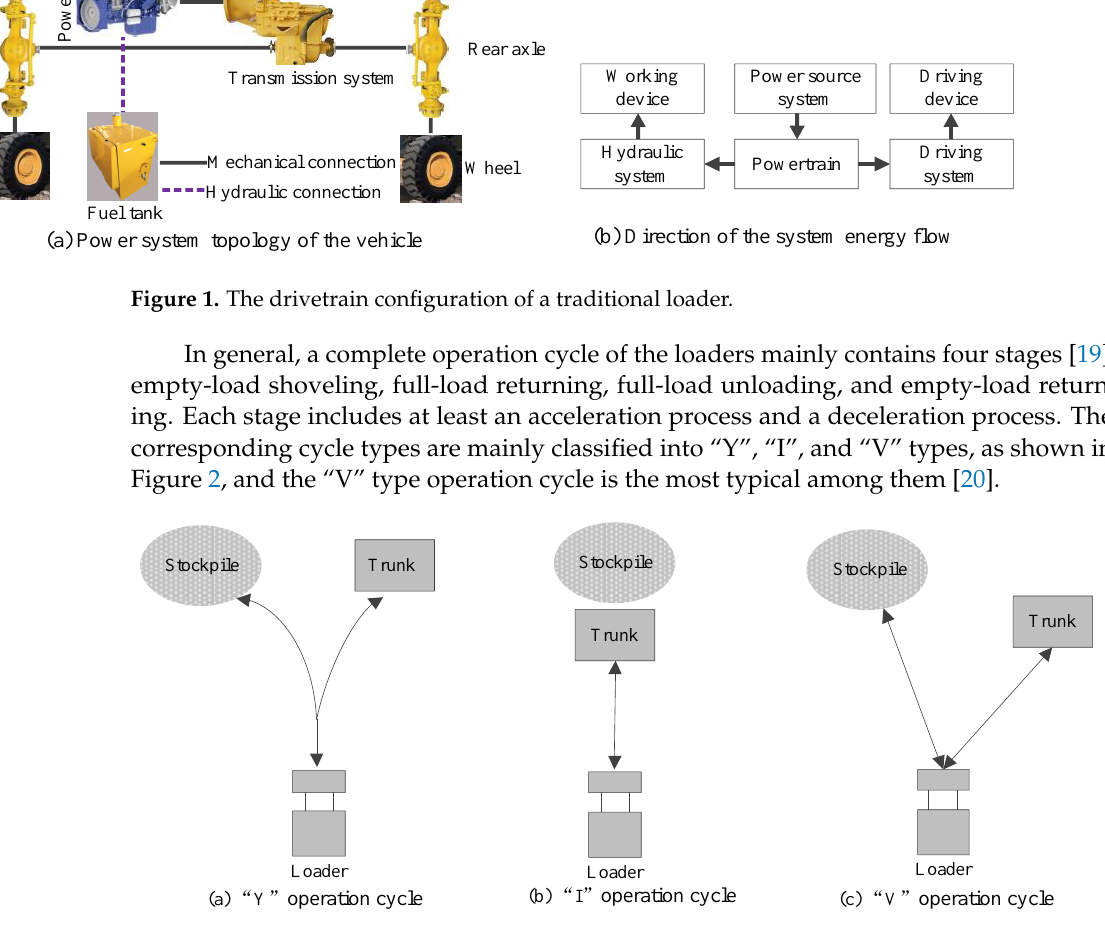
Figure 3. Operation characteristics of a loader under “V” cycle.